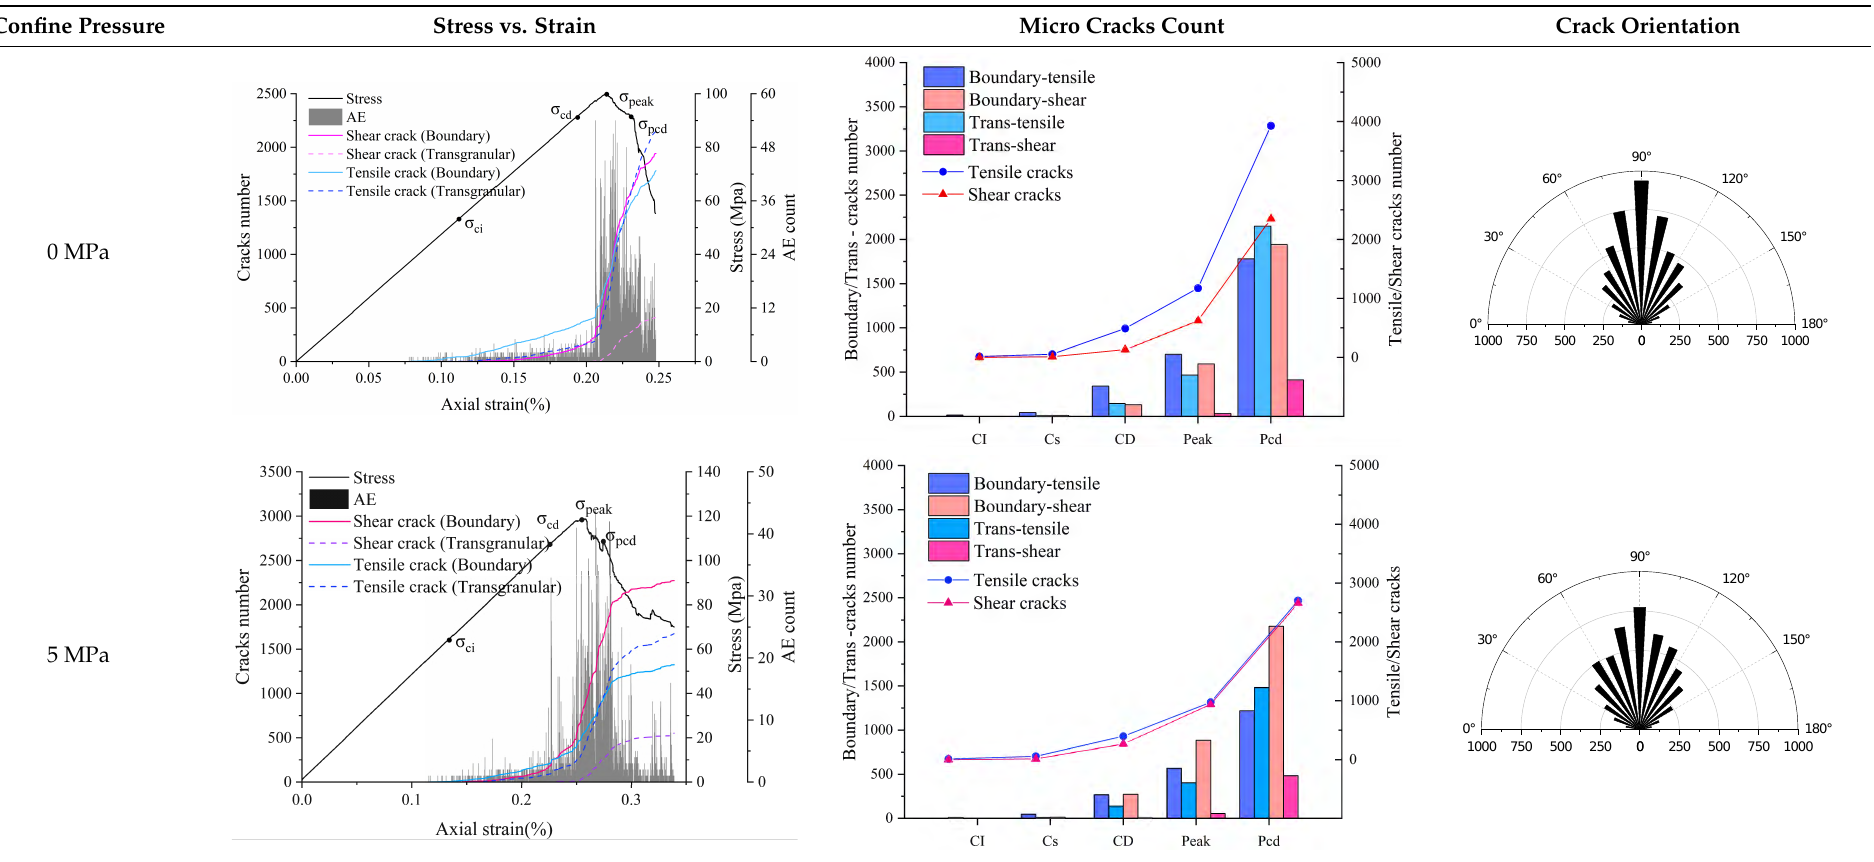
Table 5. Analysis of numerical simulation results: Comparison of granite microcracks under different confining pressure conditions (0–20 MPa). Note: ‘Cs’ in crack statistics represents the occurrence of shear cracks.